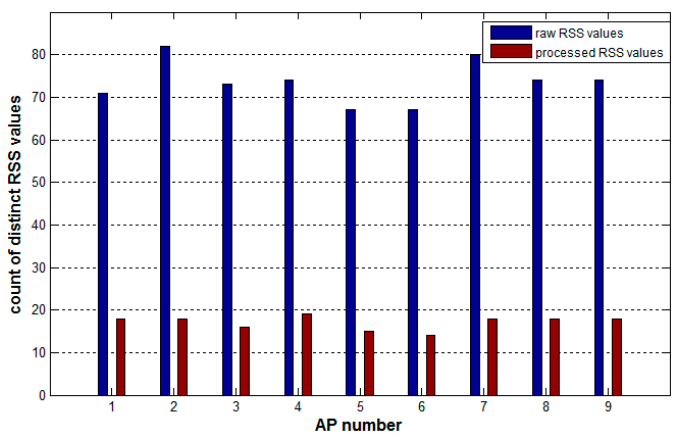
Figure 5. Comparison of the number of distinct RSS values on each AP between the raw and processed samples.